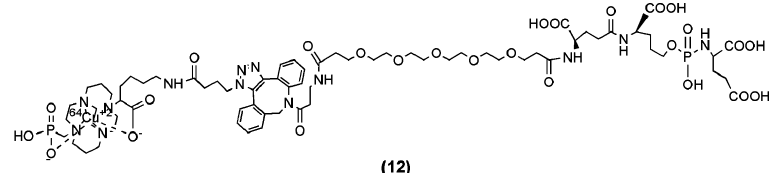
Figure 5. Chemical structure of 64 Cu-ABN-1 ( 12 ) [75].